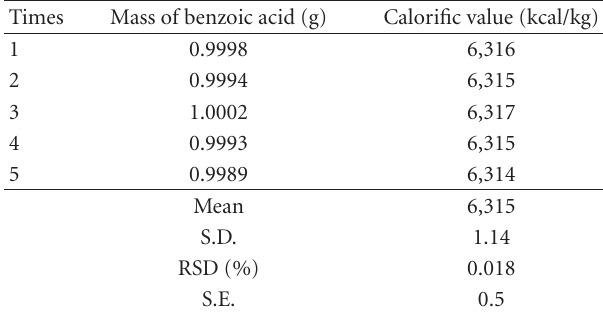
Table 3: Repeatability test of calorific analysis using benzoic acid. Times Mass of benzoic acid (g) Calorific value